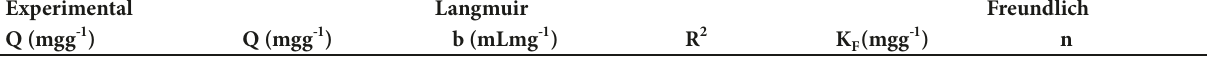
Table 1: The data calculated from the Freundlich and Langmuir isotherm equations.